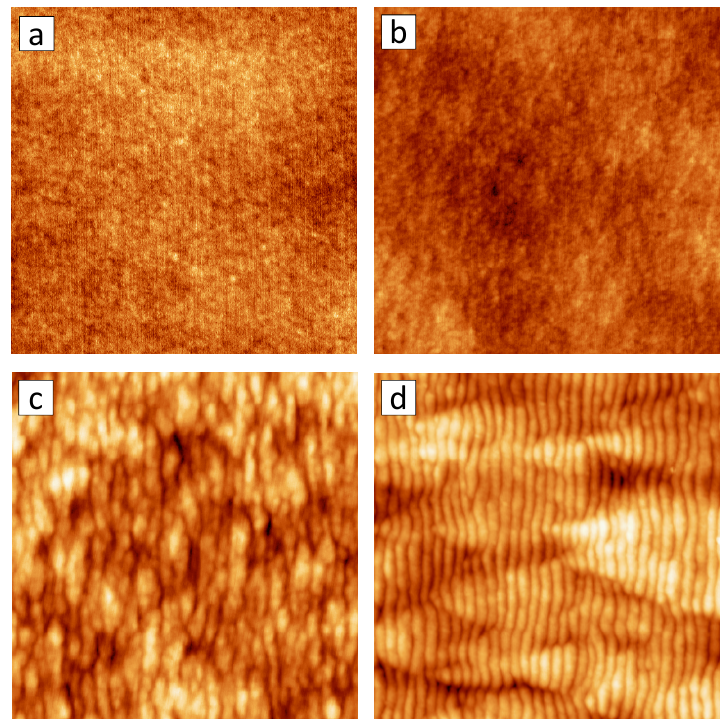
Figure 5. AFM images of Si surfaces after sputtering with 500 eV Ar ions under different angles θ : (a) θ = 30 ◦ , Φ = 5 . 7 × 10 18 cm − 2 , height scale 2 nm; (b) θ = 50 ◦ , Φ = 2 × 10 18 cm − 2 , height scale 3 nm; (c) θ = 55 ◦ , Φ = 2 × 10 18 cm − 2 , height scale 3 nm; (d) θ = 67 ◦ , Φ = 1 . 7 × 10 18 cm − 2 , height scale 10 nm. The size of the images is 1 × 1 µ m 2 ; the ion beam was entering from the